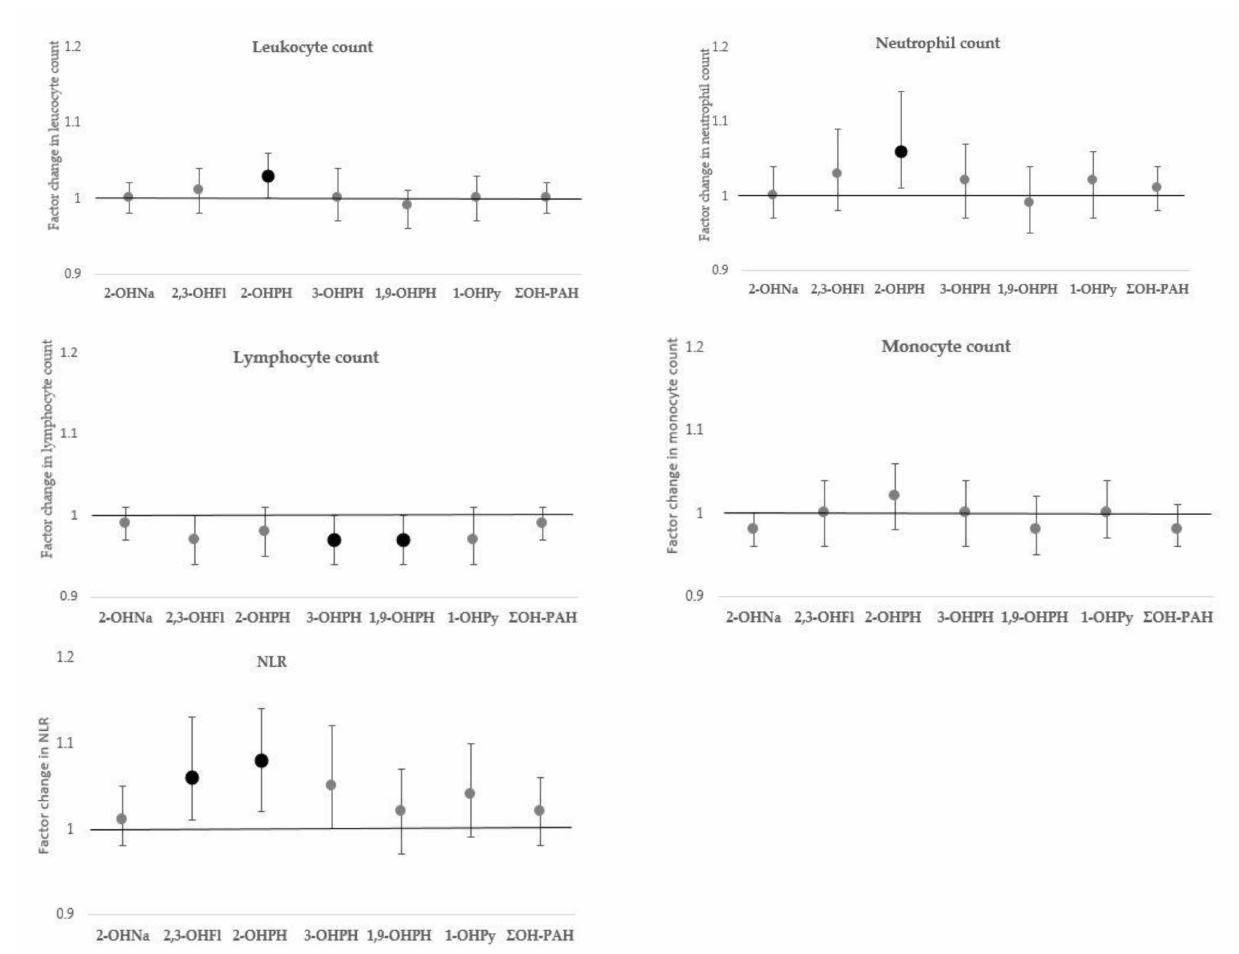
Figure 2. Associations of urinary OH-PAHs concentration with leucocyte counts and NLR in serum. Effect estimates are presented with their 95% confidence interval (95% CI) as the factor change in leucocyte count or NLR for a doubling in OH-PAH concentration. Models adjusted for sex, age, BMI, household socio-economic status, season of sampling, smoking, and residential exposure to environmental tobacco smoke. Significant associations ( p -value ≤ 0.05) are marked in bold. Abbreviations: OH-PAHs—hydroxylated polycyclic aromatic hydrocarbon; 1-OHPy—1-hydroxypyrene; 2-OHNa—2- hydroxynaphthalene; 2,3-OHFl—sum of 2-hydroxyfluorene and 3-hydroxyfluorene; 2-OHPH—2-hydroxyphenanthrene; 3-OHPH—3-hydroxyphenanthrene; 1,9-OHPH—sum of 1-hydroxyphenanthrene and 9-hydroxyphenanthrene; Σ OH-PAH— sum of molar concentrations of all measured OH-PAHs; NLR—neutrophil–lymphocyte